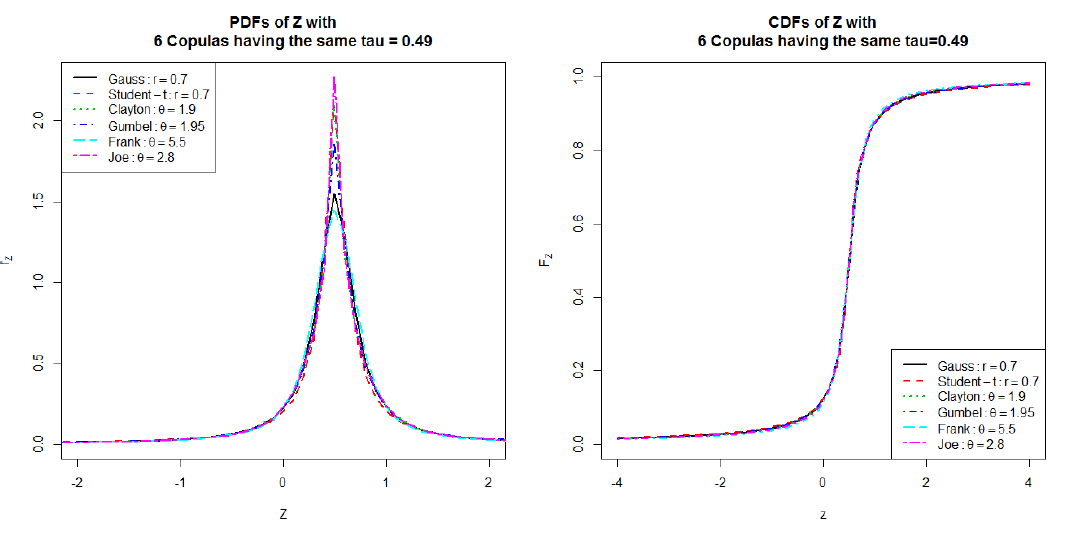
Figure 14. PDF and CDF of the ratio Z = X 1 same τ =